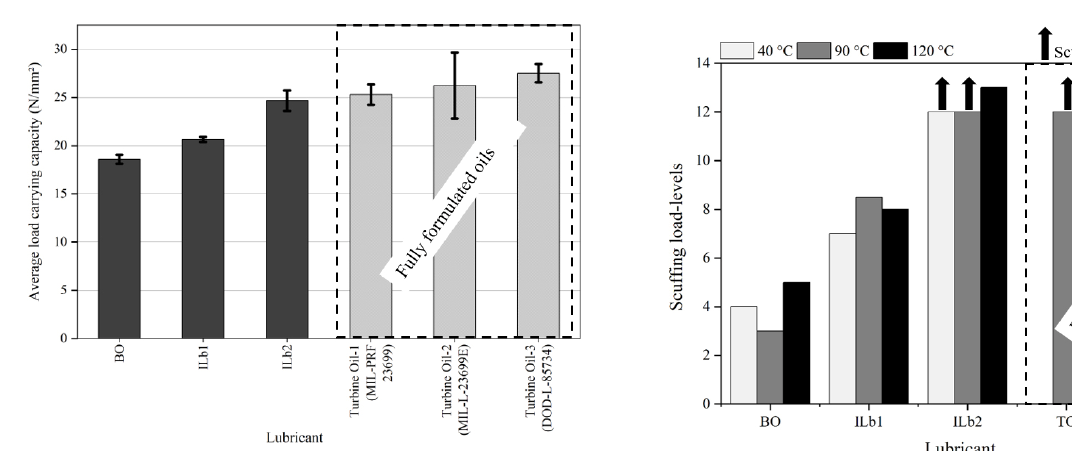
Fig. 7 FZG scuffing test results showing load-carrying capacities of the BO and ILbs in terms of load-levels tested at 40, 90, and 120 °C, and the arrows indicate the scuffing load capacities beyond load-level 12. Scuffing load-level results for fully-formulated and commercially-used aviation turbine oil (TO) and engine oil (EO) tested at 90 °C are presented on the right.